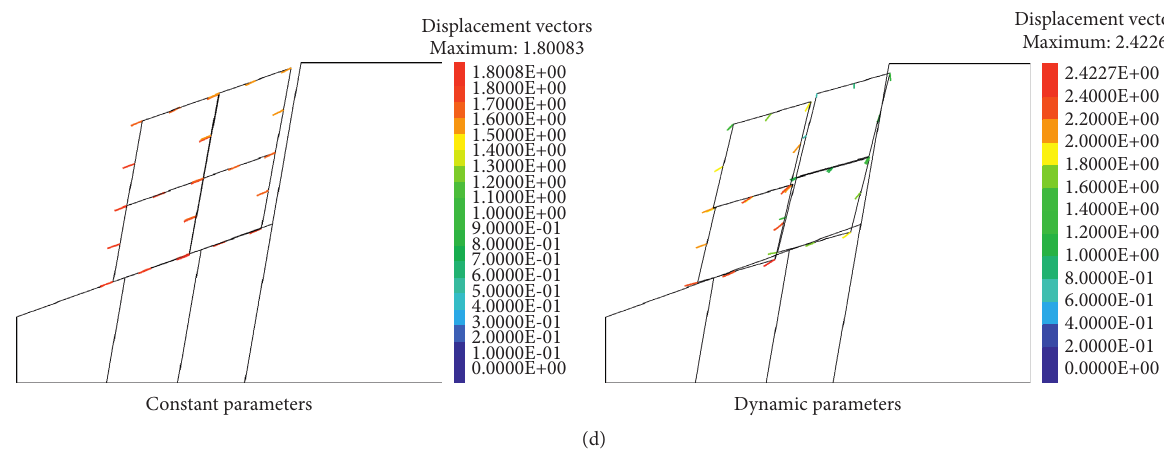
Figure 8: Displacement vector diagram of slip damage. (a) Step 200. (b) Step 400. (c) Step 600. (d) Step 800.